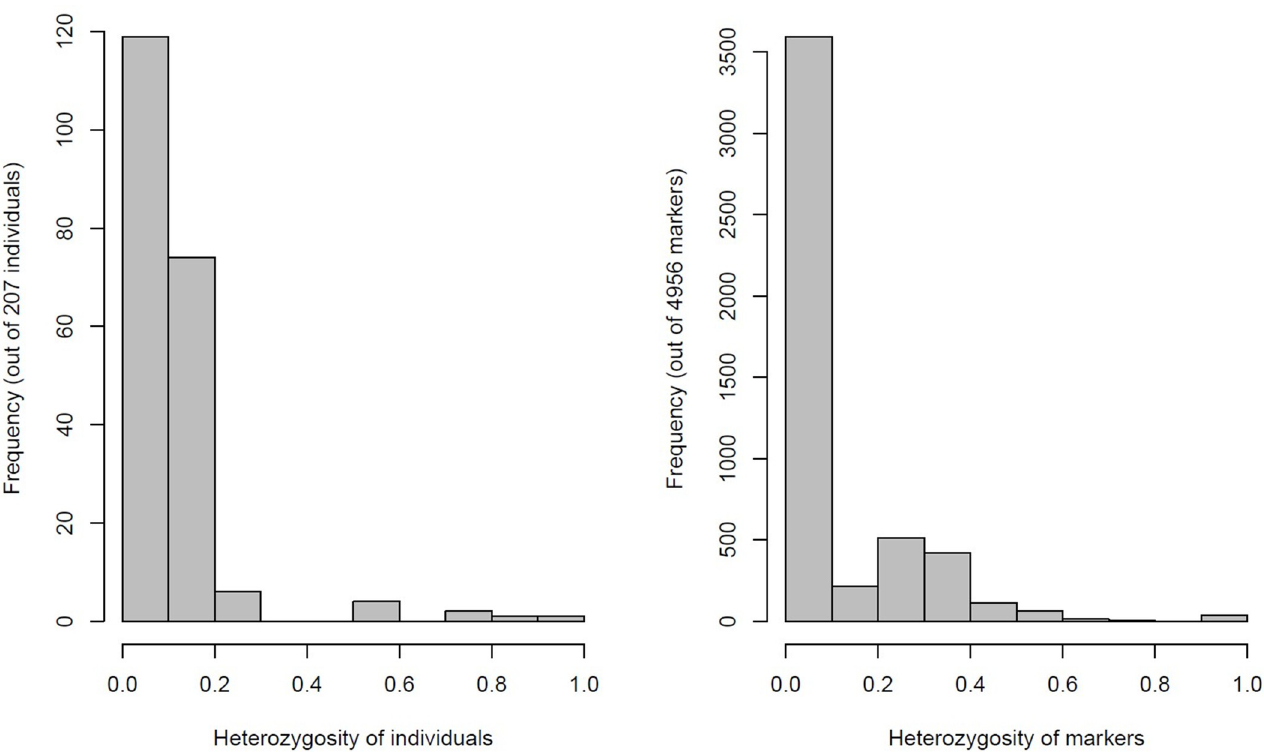
Fig 2. Frequency of heterozygous genotypes and heterozygosity of 4,957 SNP markers generated using DArTseq platform across 207 yam genotypes.